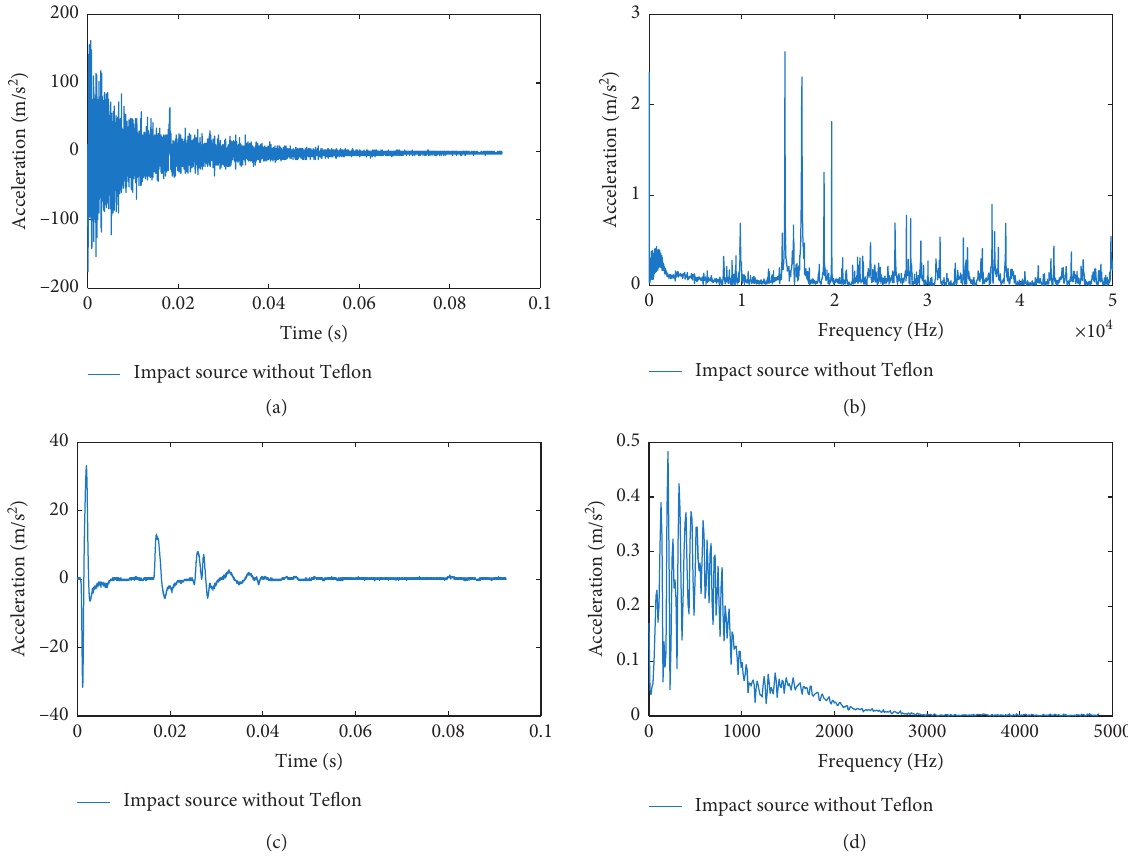
Figure 2: Time-domain waveforms and spectra of the impact source vibrations: (a) time-domain waveform without Teflon; (b) frequency spectrum without Teflon; (c) time-domain waveform with Teflon; (d) frequency spectrum with